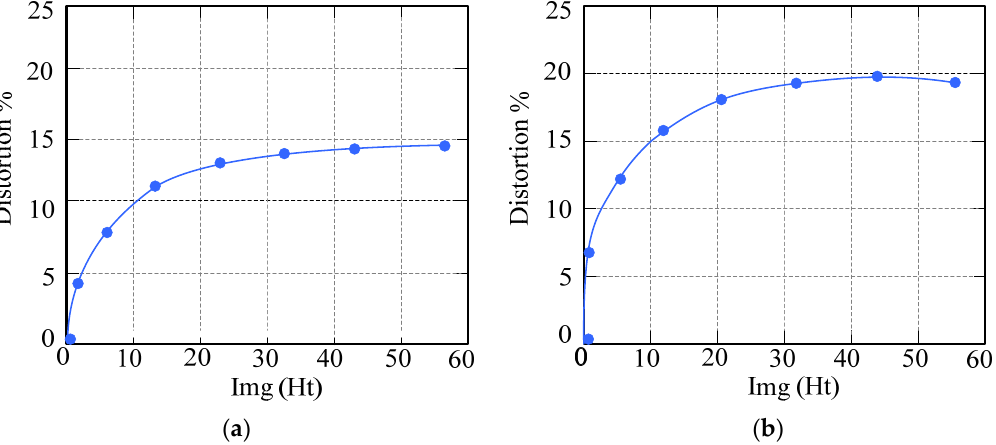
Figure 10. Distortion contrast curve. ( a ) System design distortion data in this paper, ( b ) Traditional sample distortion data.